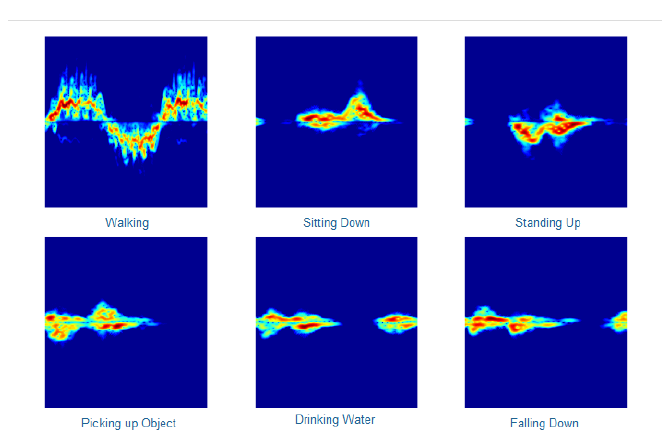
Figure 1. Raw spectrogram examples of each activity [18].